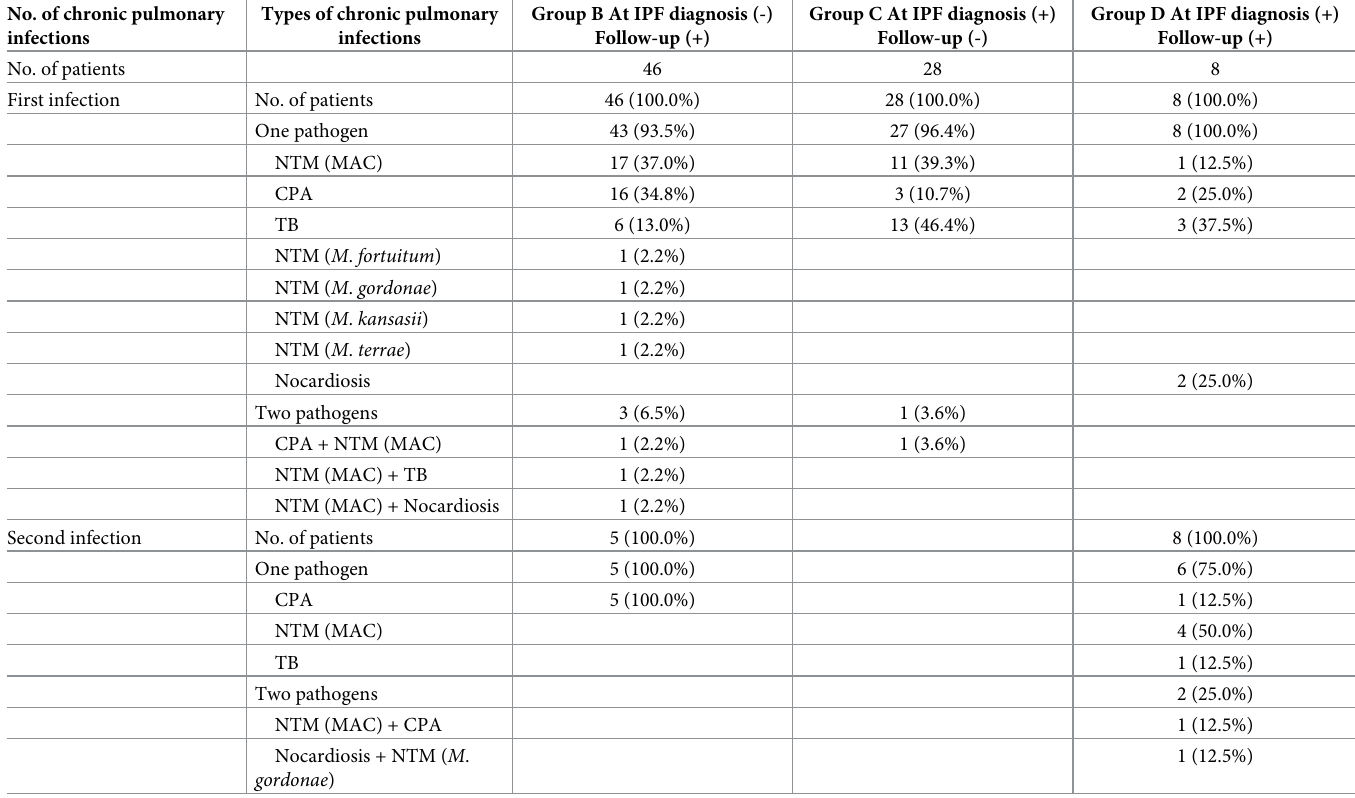
Table 2. Chronic pulmonary infections in patients with idiopathic pulmonary fibrosis (IPF) at IPF diagnosis and during follow-up. No. of chronic pulmonary